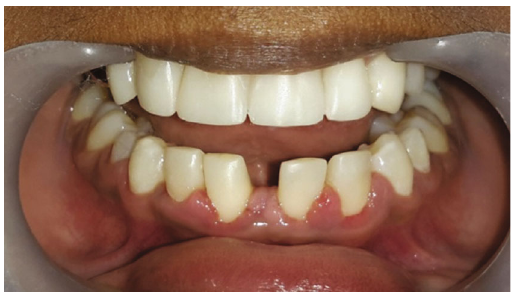
Figure 11: All conical incisors were recontoured with LCC. Figure 12: RBB was cemented to replace missing lower central